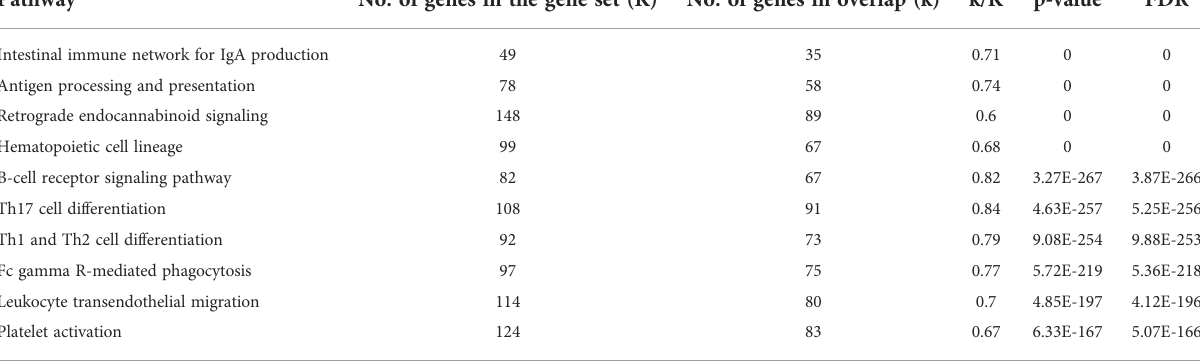
TABLE 2 Pathway analysis of the 200 genes with the lowest p-value among the 703 genes with concordant fold change across murine cells, human Heart Cell Atlas data, and primary sorted cells in myocardial vs. peripheral blood B-cell comparisons. Pathway No. of genes in the gene set (K) No. of genes in overlap (k) k/K p-value FDR